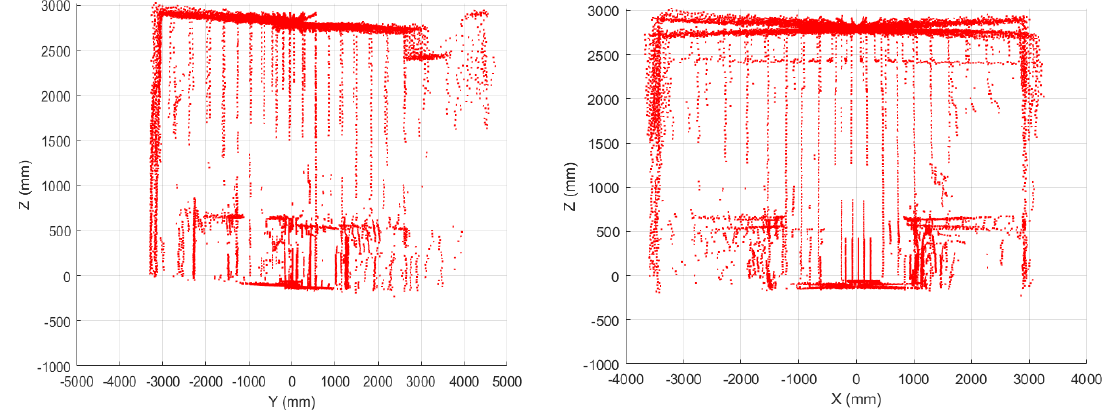
Figure 12. 2D reconstructions from LiDAR data: planes yz and xz.